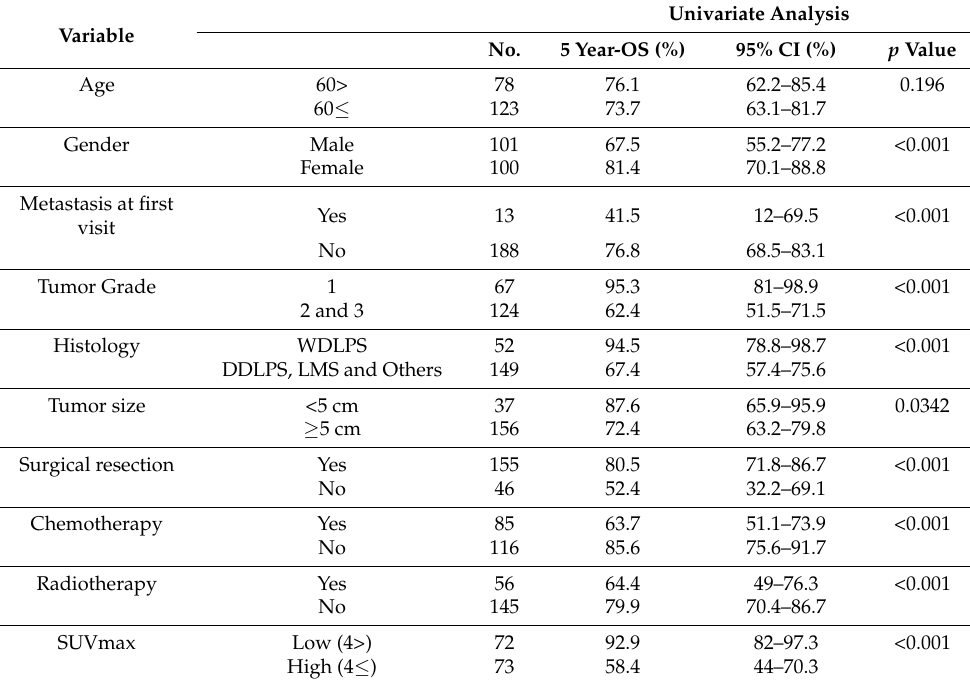
Table 3. Analyses on survival in all RPS